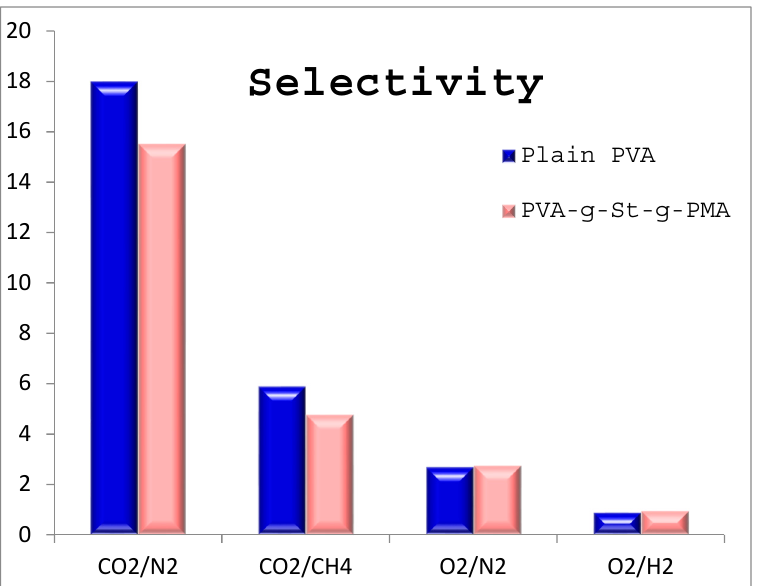
Figure 7. Selectivity data for CO 2 /N 2 , CO 2 /N 2 , O 2 /N 2 , O 2 /H 2 gases for plain PVA and PVA-g-St-g- PMA membrane.